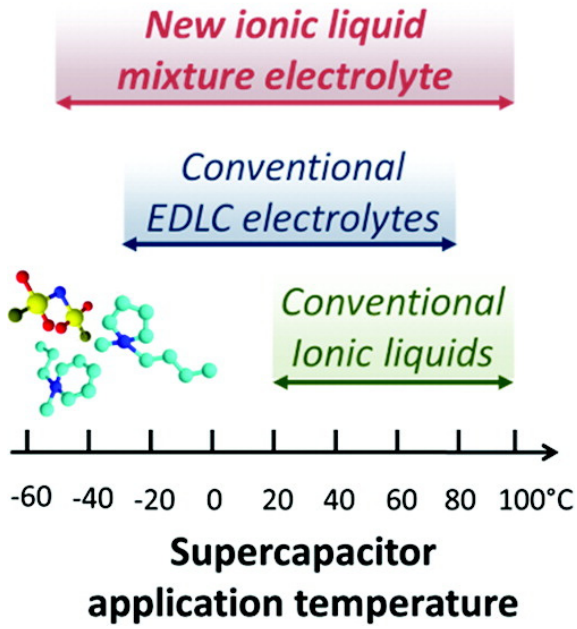
Figure 8. Extended operating temperature range of SCs based on eutectic ILs mixture. Reprinted 2011 from [89] with permission from the American Chemical Society.